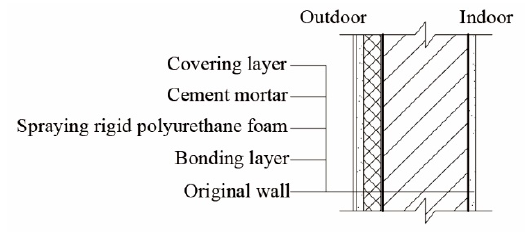
Figure 30. Internal thermal insulation.